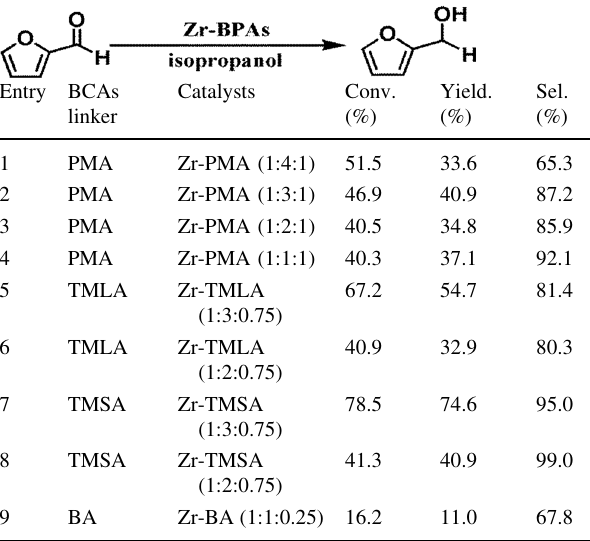
Table 1 Screening of the Zr-BCAs catalysts for the conversion of furfural into FAL